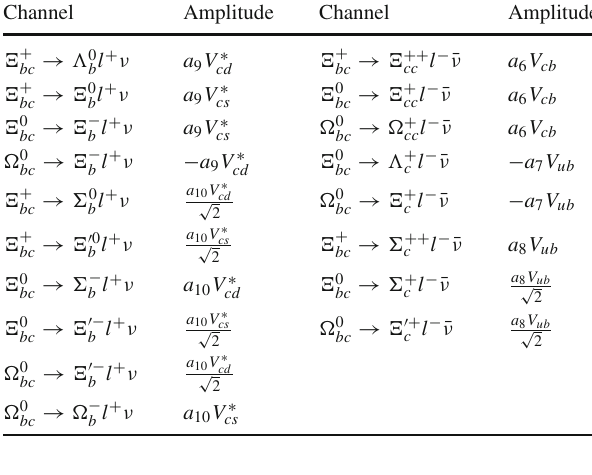
Table 4 Similar to Table 2 but for the doubly heavy bcq baryons